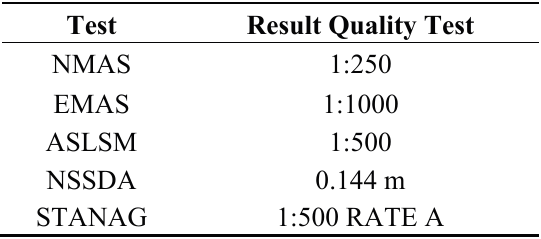
Table 1. Summary of results for each spatial quality